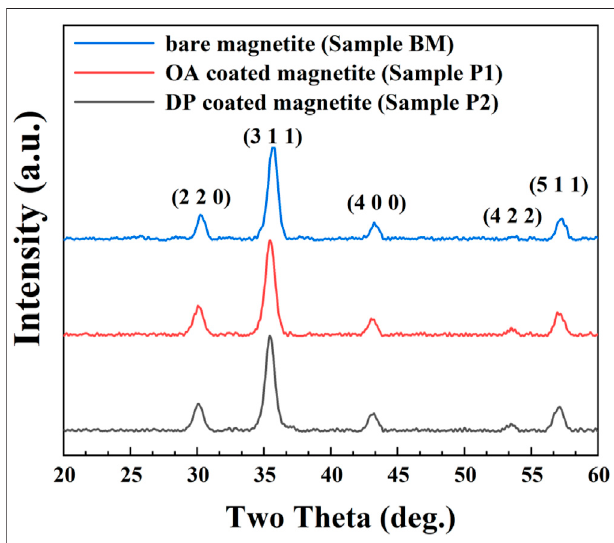
FIGURE 2 | XRD patterns of bare magnetite particles (BM), OA-coated particles (sample P1), and DP-coated magnetic nanoparticles (sample P2).